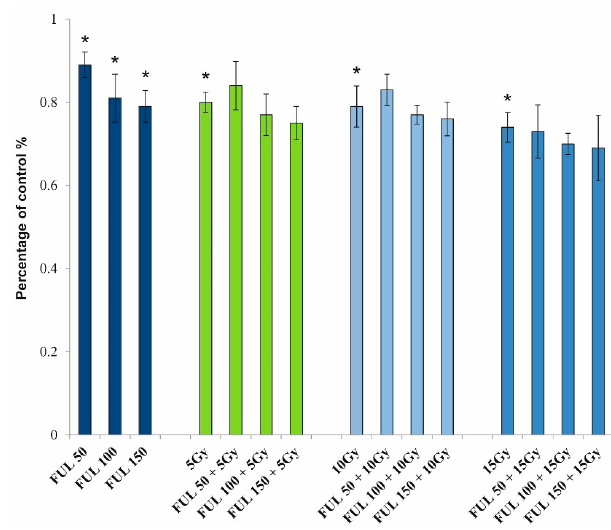
Figure 10. Mitochondrial membrane potential of PBMCs. PBMCs were incubated with fullerenol C 60 (OH) 36 (50, 100, and 150 mg/L) for 24 h (37 °C, 5% CO 2 atmosphere, 100% relative humidity) and irradiated with the doses of 5, 10, and 15 Gy. The presented values are the fraction of untreated cells (control) for which the value was set at 1.0. Bars represent mean values with standard deviations. Asterisks are used to mark values that are statistically different in comparison with control values (* p < 0.05). All experiments were repeated 4 times.